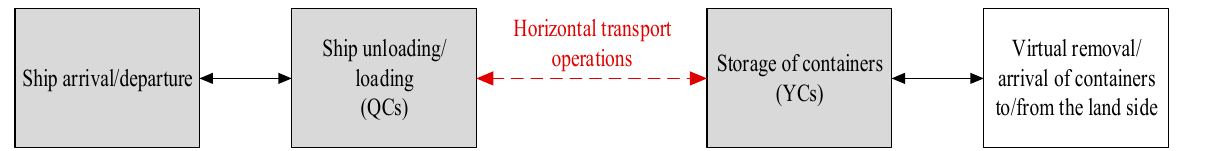
Figure 2. Simulated terminal operations.